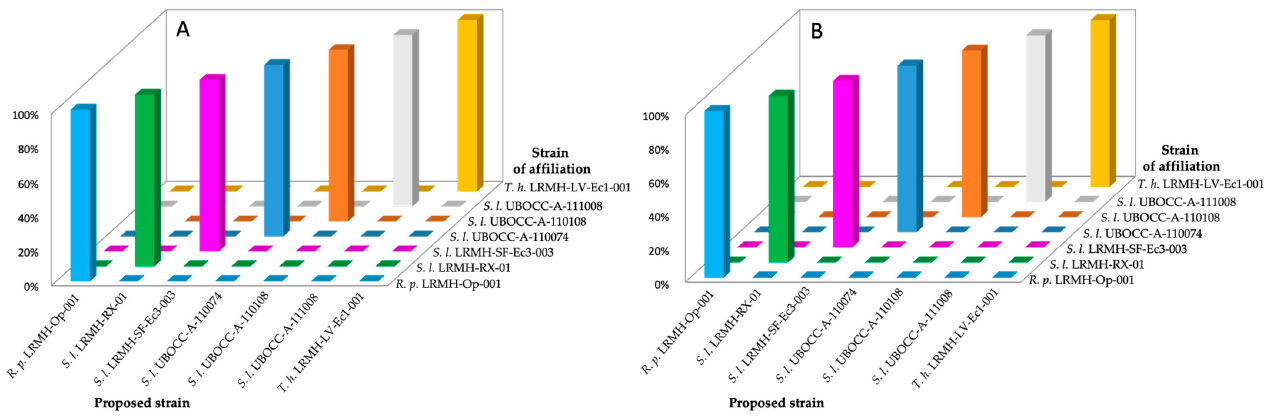
Figure 3. Confusion matrix obtained for the discrimination of the strains after growth on the PES membrane and scraping the surface of the membrane to harvest the mycelium. Min–max normalization ( A ), Vector normalization ( B ). R. p. , Rhodonia placenta . S. l. , Serpula lacrymans . T. h. , Trichoderma harzianum .